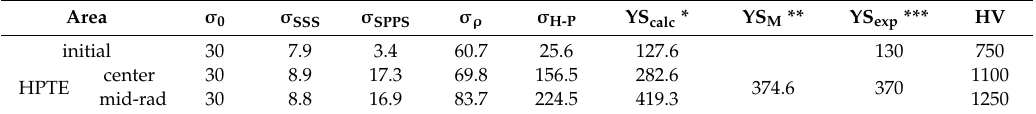
Table 4. Contributions (all are given in MPa) of various strengthening mechanisms in CP Cu before and after HPTE. The testing sample contained central and mid-radius areas of the